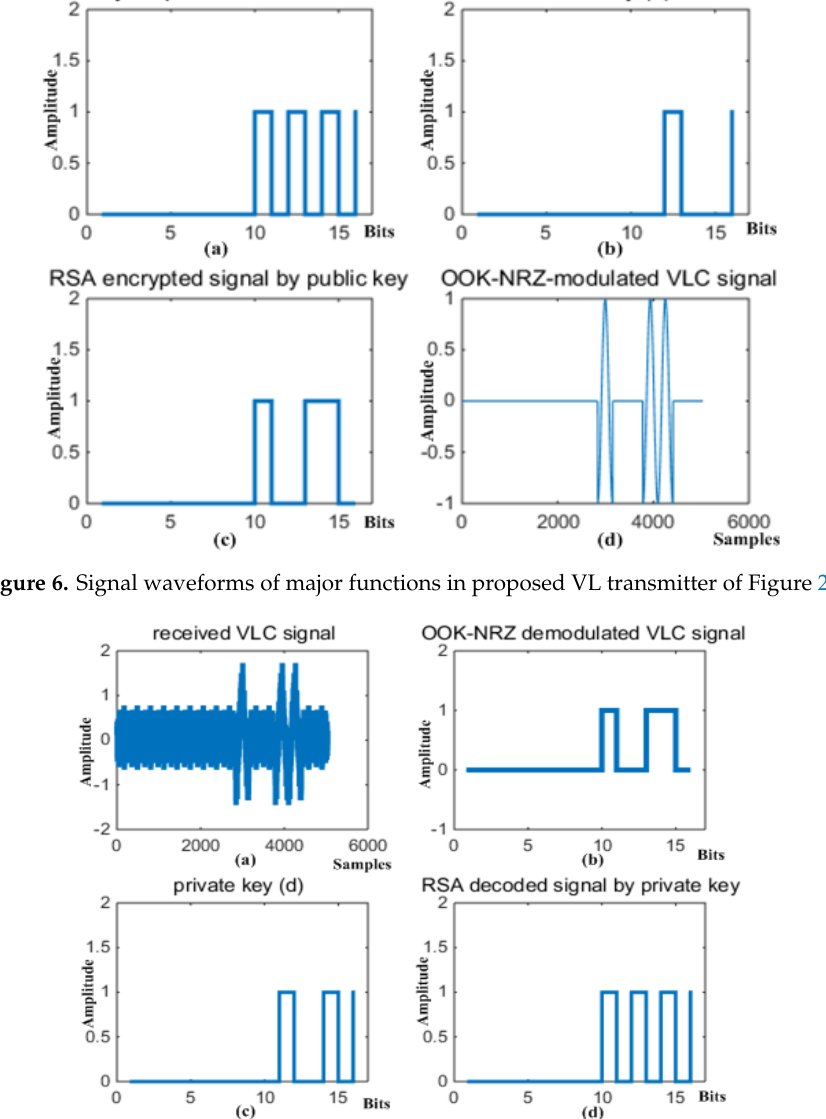
Figure 7. Signal waveforms of major function outputs in proposed VL receiver of Figure 2b.